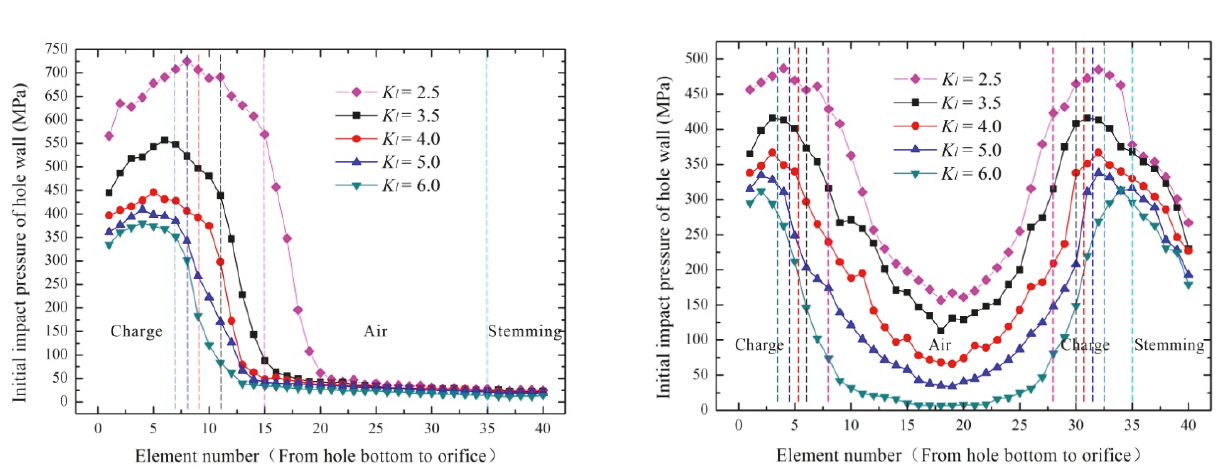
Figure 12: Initial shock pressure of borehole wall with upper air- decked charging structure.